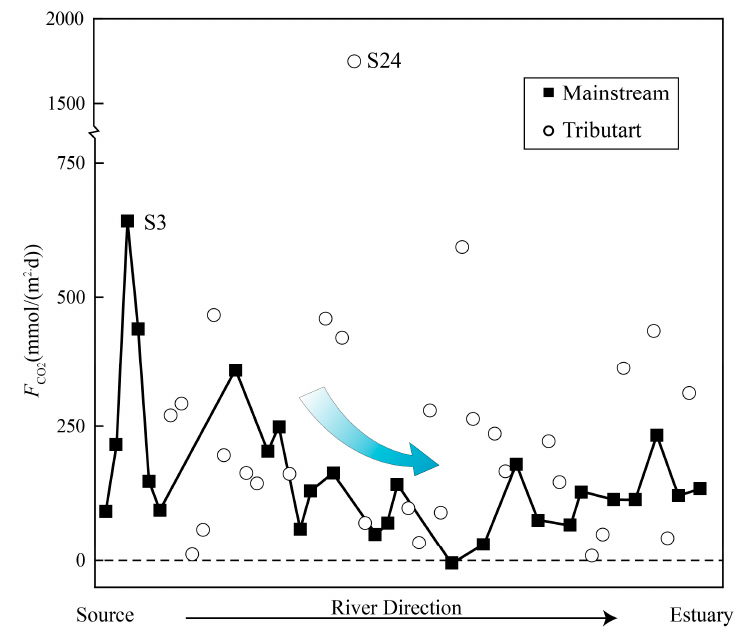
Figure 7. Spatial distributions of F CO2 in the Mun River. Table 1. The average p CO 2 and CO 2 evasion flux of the Mun River and other rivers around the world.